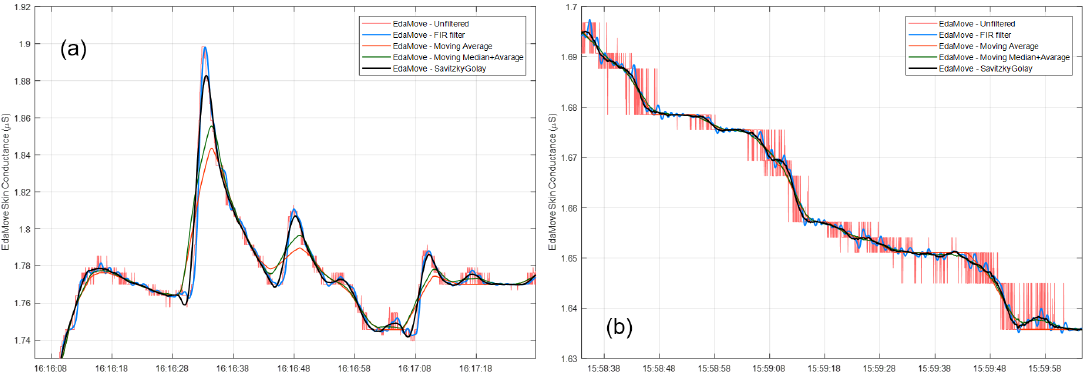
Figure 5. Comparison of EdaMove signals before and after applying various filtering/smoothing techniques at two different time periods ( a , b